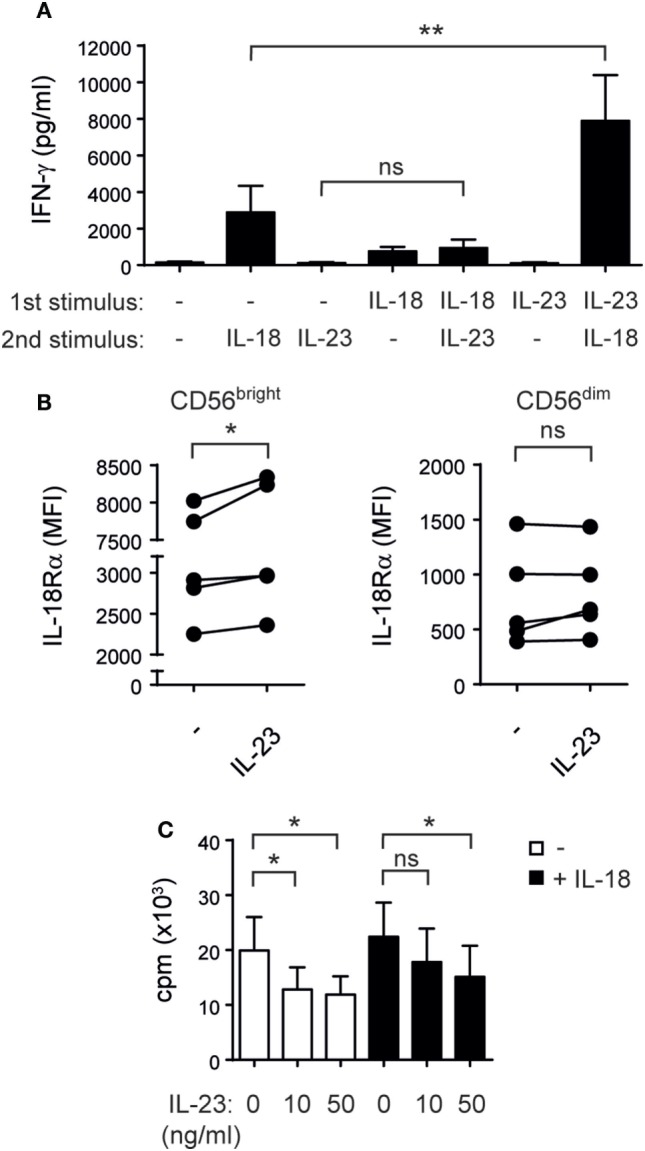
Interleukin (IL)-23 primes natural killer (NK) cells for IL-18-driven IFN-γ secretion upregulating IL-18Rα and inhibits NK cell proliferation. (A) IFN-γ secretion by NK cells cultured overnight in the absence (−) or in the presence of IL-23 or IL-18 (“first stimulus”), washed, and thereafter incubated for 24 h in the absence (−) or in the presence of IL-23 or IL-18 (“second stimulus”); n = 7. (B) IL-18Rα expression on sorted CD56bright and CD56dim NK cells cultured overnight in the absence (−) or in the presence of IL-23; n = 5. (C) Proliferation of NK cells incubated for 5 days with 1 ng/ml of IL-15 and the indicated doses of IL-23 in the absence (white bars) or in the presence of 10 ng/ml of IL-18 (black bars); n = 6. Mean ± SEM are shown. ns, not significant; *p < 0.05; **p < 0.01; one-way ANOVA with repeated measures and Bonferroni’s post hoc test.